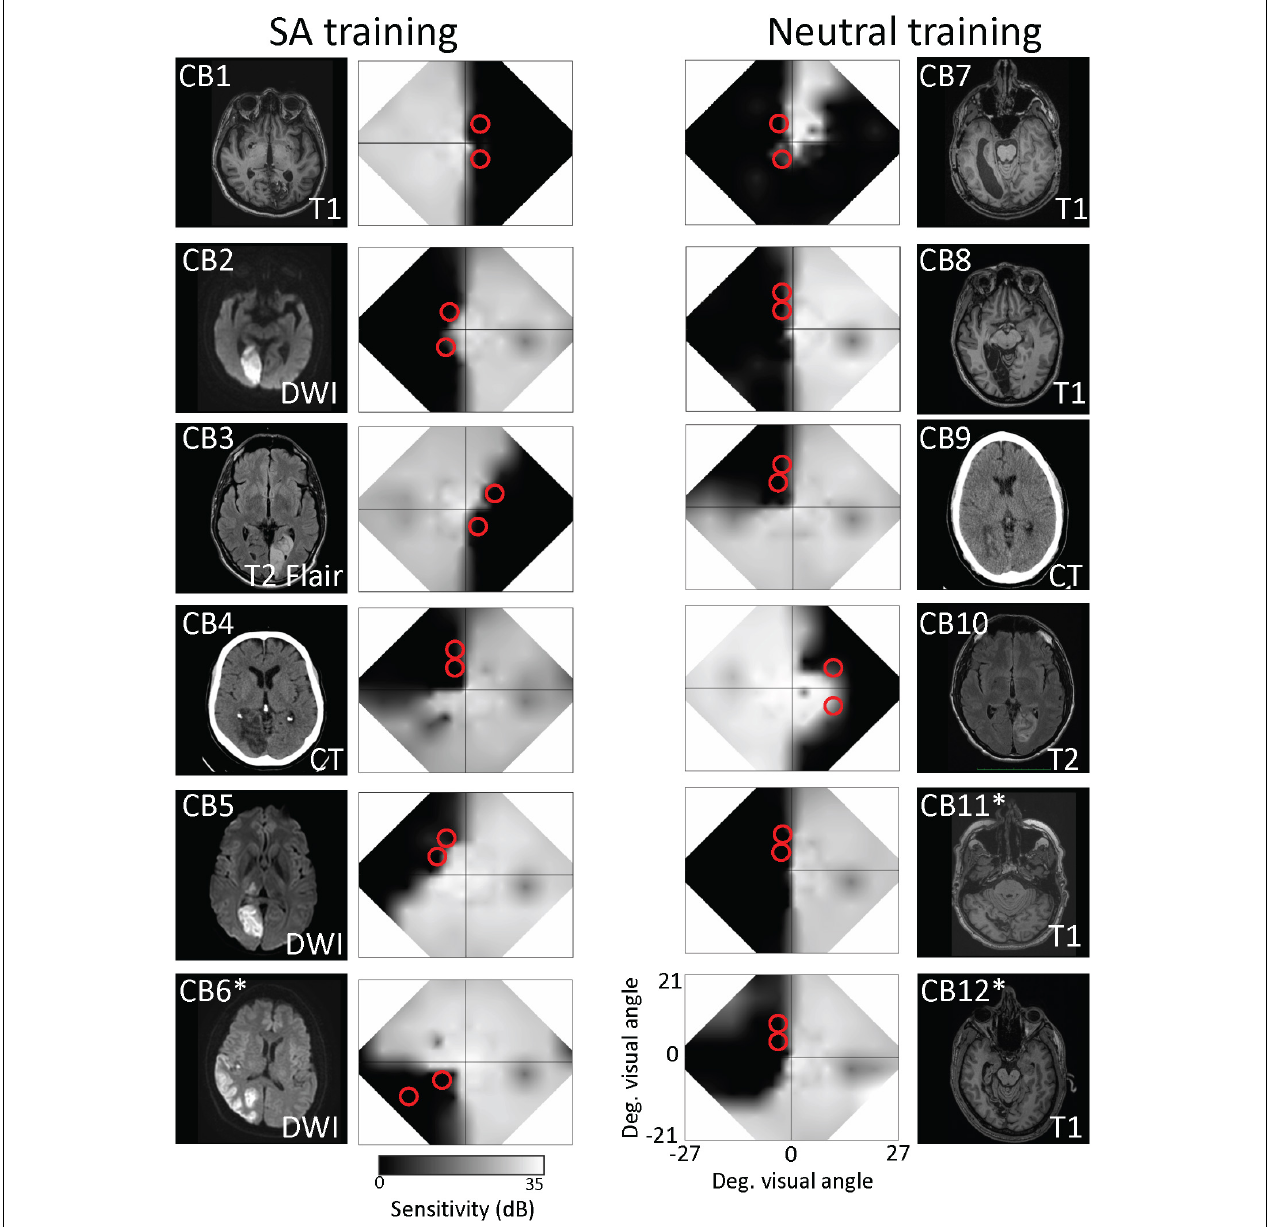
FIGURE 1 | Brain lesions and visual field characteristics of recruited participants. Structural brain scans show locations of stroke-induced damage in the occipital cortex in horizontal sections. Right and left-brain hemispheres are shown according to radiological standards (right brain on image left). Imaging type [MRI T1, diffusion-weighted imaging (DWI), T2-weighted fluid-attenuated inversion recovery (T2-FLAIR), or computed tomography (CT)] is indicated on each image. Patients who did not complete the study are asterisked. Adjacent to each brain image is a composite, binocular map of the central visual field generated from monocular 24–2 and 10–2 Humphrey automated perimetry at baseline. Red circles on each map denote the approximate locations and size of training stimuli.